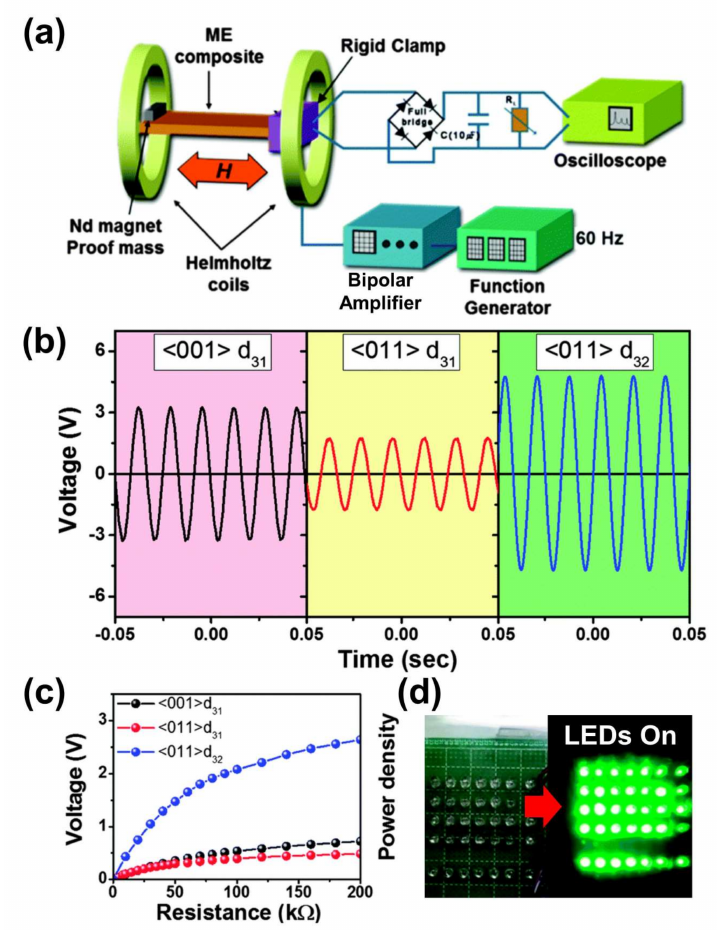
Figure 4. ( a ) Schematic diagram of MME generator measurement setup. ( b ) Output voltage response from MME generator embedded with <011> SFC in d 32 mode under 160 µ T and 60 Hz. ( c )